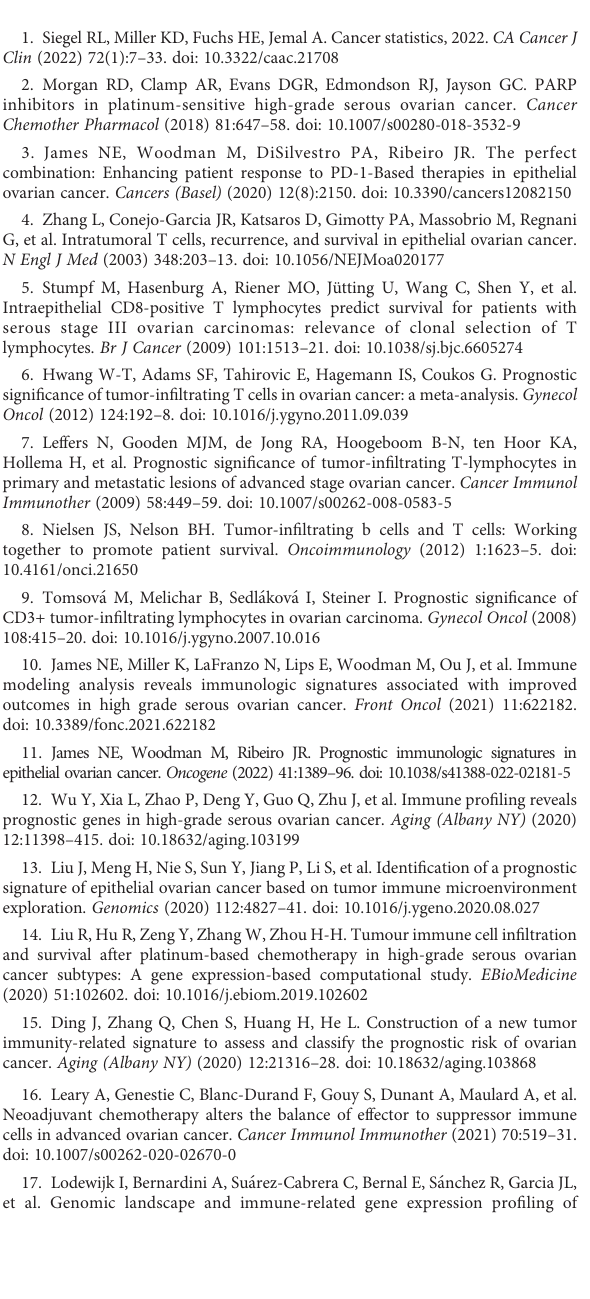
SUPPLEMENTARY TABLE 5 All post-NACT differentially expressed genes between patients with ≤ 12 mo PFI versus those with >12 mo